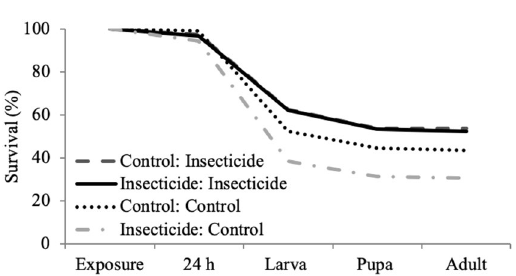
Figure 3. Within- and transgenerational insecticide stress effects on survival (%) between different life stages in the second generation Colorado potato beetles. Within-generational insecticide stress exposure decreases larval and pupal survival within the 24 h when compared to control group. Transgenerational insecticide treatment decreases larval mortality when compared to larvae descending from control mothers. Insecticide: Control within-generational treatment: transgenerational treatment means that within generational treatment was insecticide stress and transgenerational treatment was